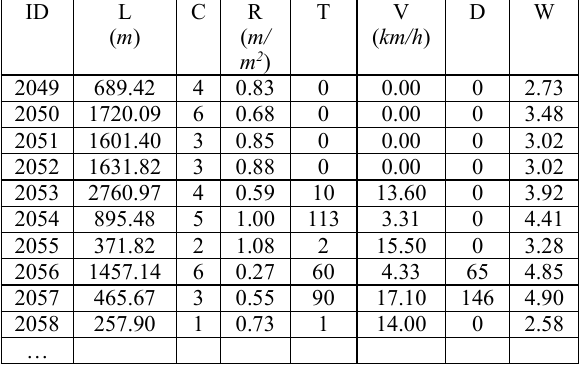
Table 3. Road properties and importance from 16 to 17 p.m.